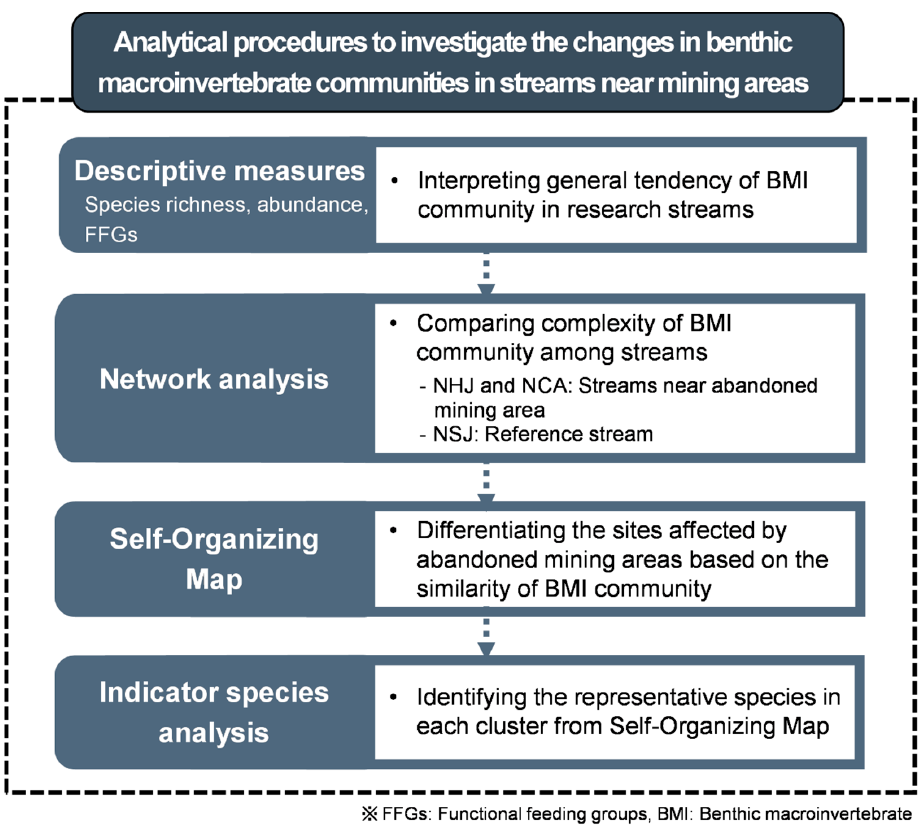
Figure 2. The procedure for data analysis.